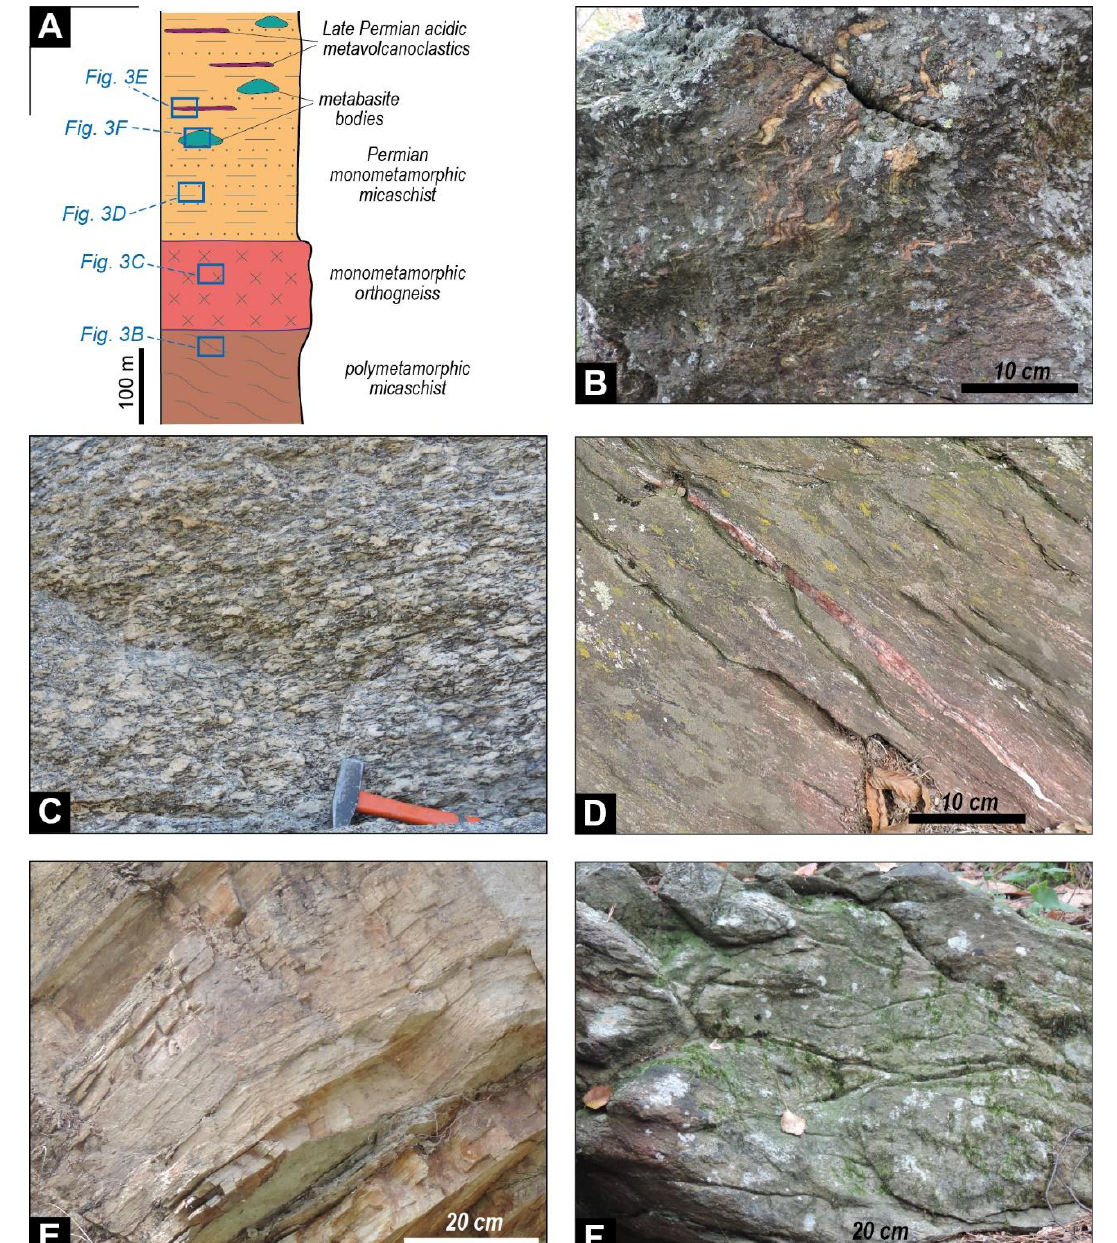
Figure 3. ( A ) Pre-Alpine stratigraphic columnar section of the Dronero Unit (the stratigraphic location of the representative field images is shown); ( B ) close-up view of the polymetamorphic micaschist (South of Valmala); ( C ) close-up view of the monometamorphic metagranitoid (West of Mt. S.Beranardo); ( D ) close-up view of the Permian monometamorphic micaschist (North of Dronero); ( E ) view of the outcrop of micro-augen gneiss selected for U/Pb dating (North of Dronero); ( F ) close-up view of a metabasite body with nodular texture hosted in the monometamorphic micaschist (North of Dronero).